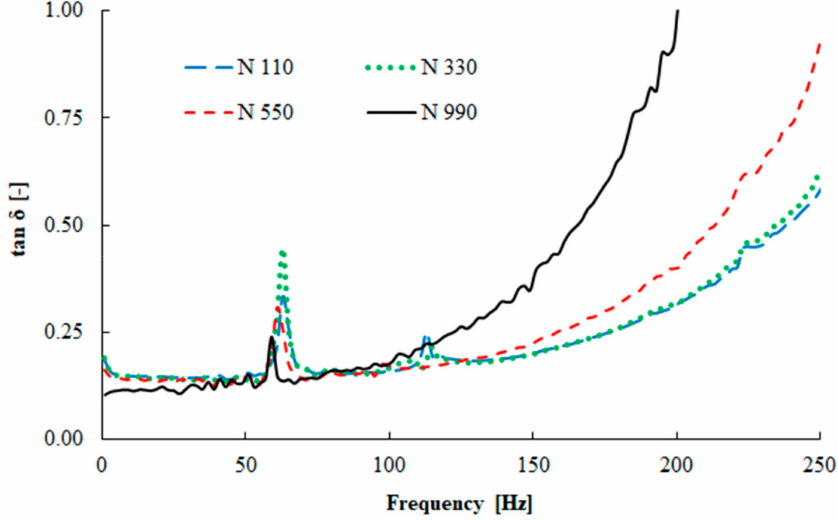
Figure 6. Frequency dependence of the loss factor (displacement x = 5 µ m, T = 25 ◦